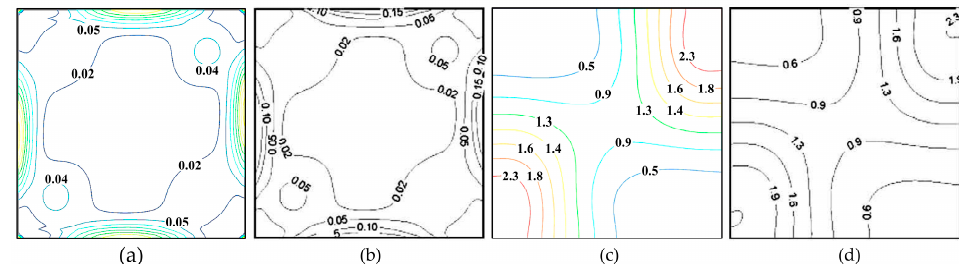
Figure 3. Comparison of local entropy generation contours caused by heat transfer irreversibility ( a , b ) and caused by fluid friction ( c , d ). Parts ( a ) and ( c ) show the obtained data, while parts ( b ) and ( d ) show the literature data [6]. Parts ( b , d ) are reprinted with permission from Ref. [6]. 2008, Elsevier Ltd.